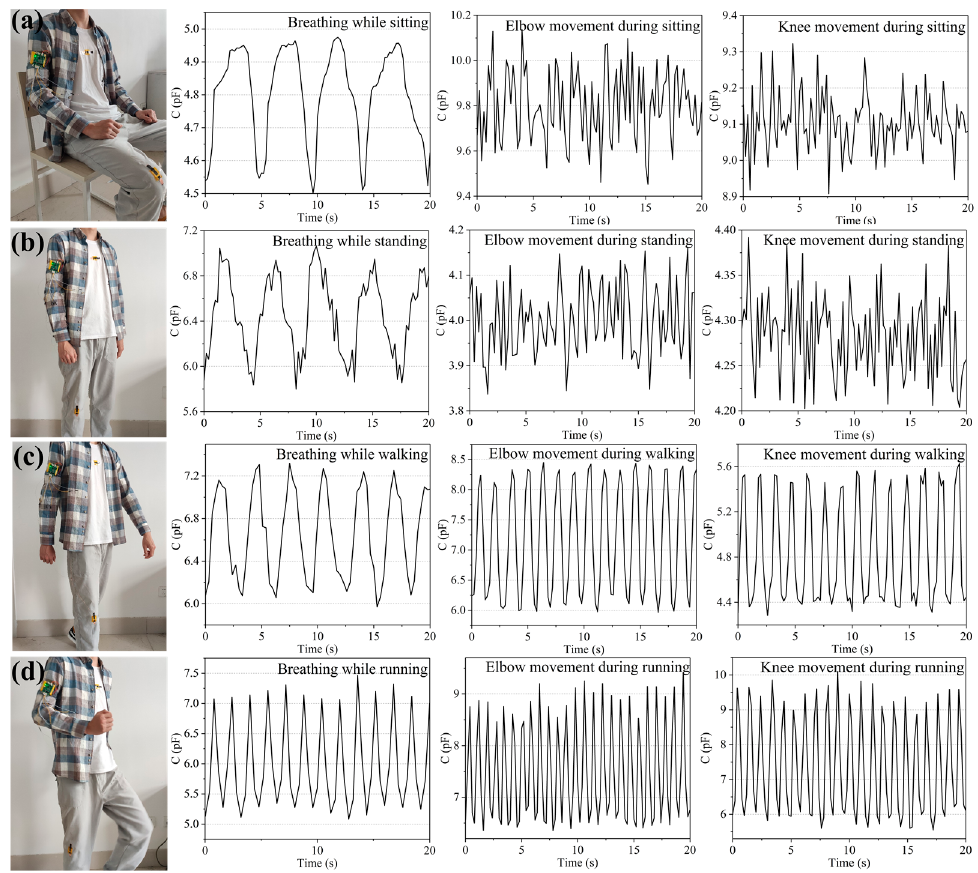
Figure 13. Capacitance response of the sensor in different motion states. The sensor capacitance changes in the state of ( a ) sitting, ( b ) standing still, ( c ) walking, and ( d ) running.